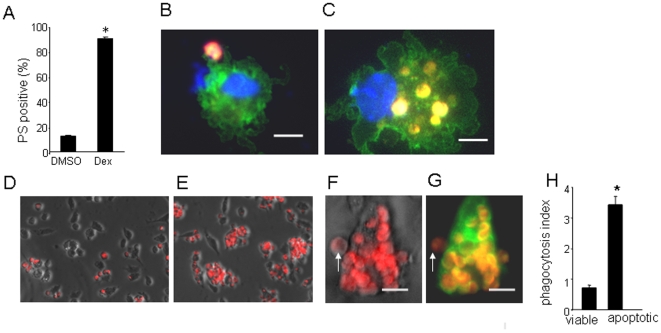
Dead cell clearance by wound-site macrophages.For dead cell clearance assay, wound macrophages were co-cultured with cell-tracker labeled (red) thymocytes. A, Thymocyte apopotosis detected using Annexin V (FITC conjugated). Annexin V binds to externalized phosphatidyl serine (PS), a characteristics of apoptotic cells. Such treatment resulted in over 90% cells becoming phosphatidylserine (PS) positive. Data are mean ± SD; p<0.05 (n = 4). B, F4/80-FITC (green) and DAPI (blue, nuclear) stained wound macrophage establishing link with an apoptotic thymocyte (red); C, wound macrophage (F4/80-FITC and DAPI stained) engulfed a number of red apoptotic thymocytes; D, co-cultures of control (untreated, viable) thymocytes (red) with wound macrophage (DIC image) followed by wash; E, co-cultures of apoptotic thymocytes (red) with wound macrophages (differential image contrast, DIC image) followed by wash; F–G, Representative high magnification image of a macrophage in DIC (F) or stained with F4/80 FITC (green, G) showing engulfed and adhered (white arrows) apoptotic thymocytes (red). H, scoring of thymocytes engulfed by macrophage. Data are presented as phagocytic index which is defined as total number of apoptotic cells engulfed by macrophages in a field of view divided by total number of macrophage presented in the view. This approach enables normalization of the data against macrophage number. Data presented as mean ± SD (n = 3). *, p<0.01 compared to macrophage co-cultured with control thymocytes.